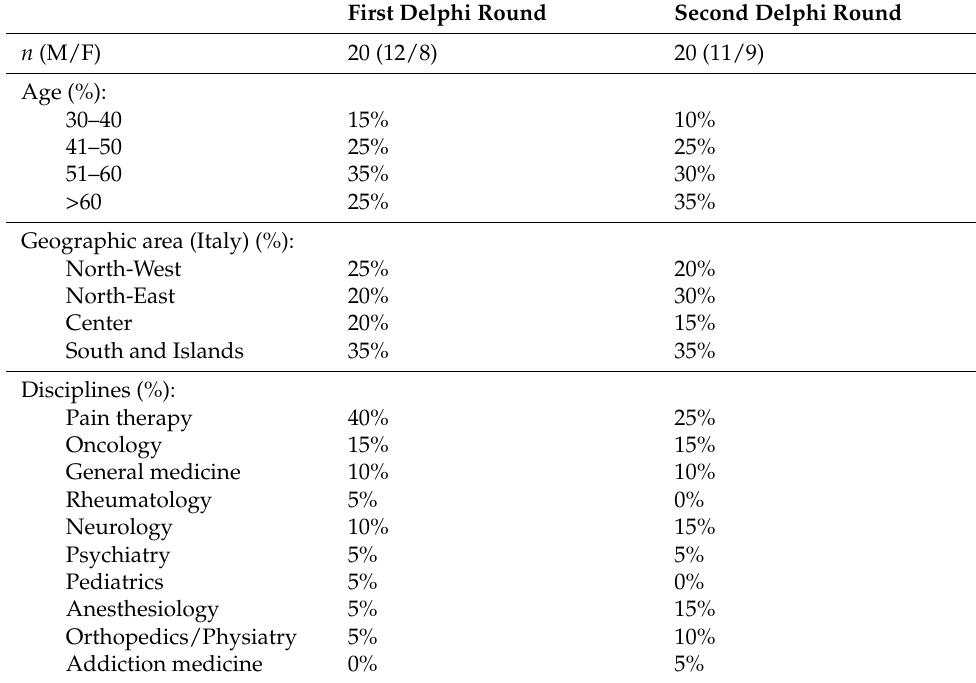
Table 2. Expert panel respondents.